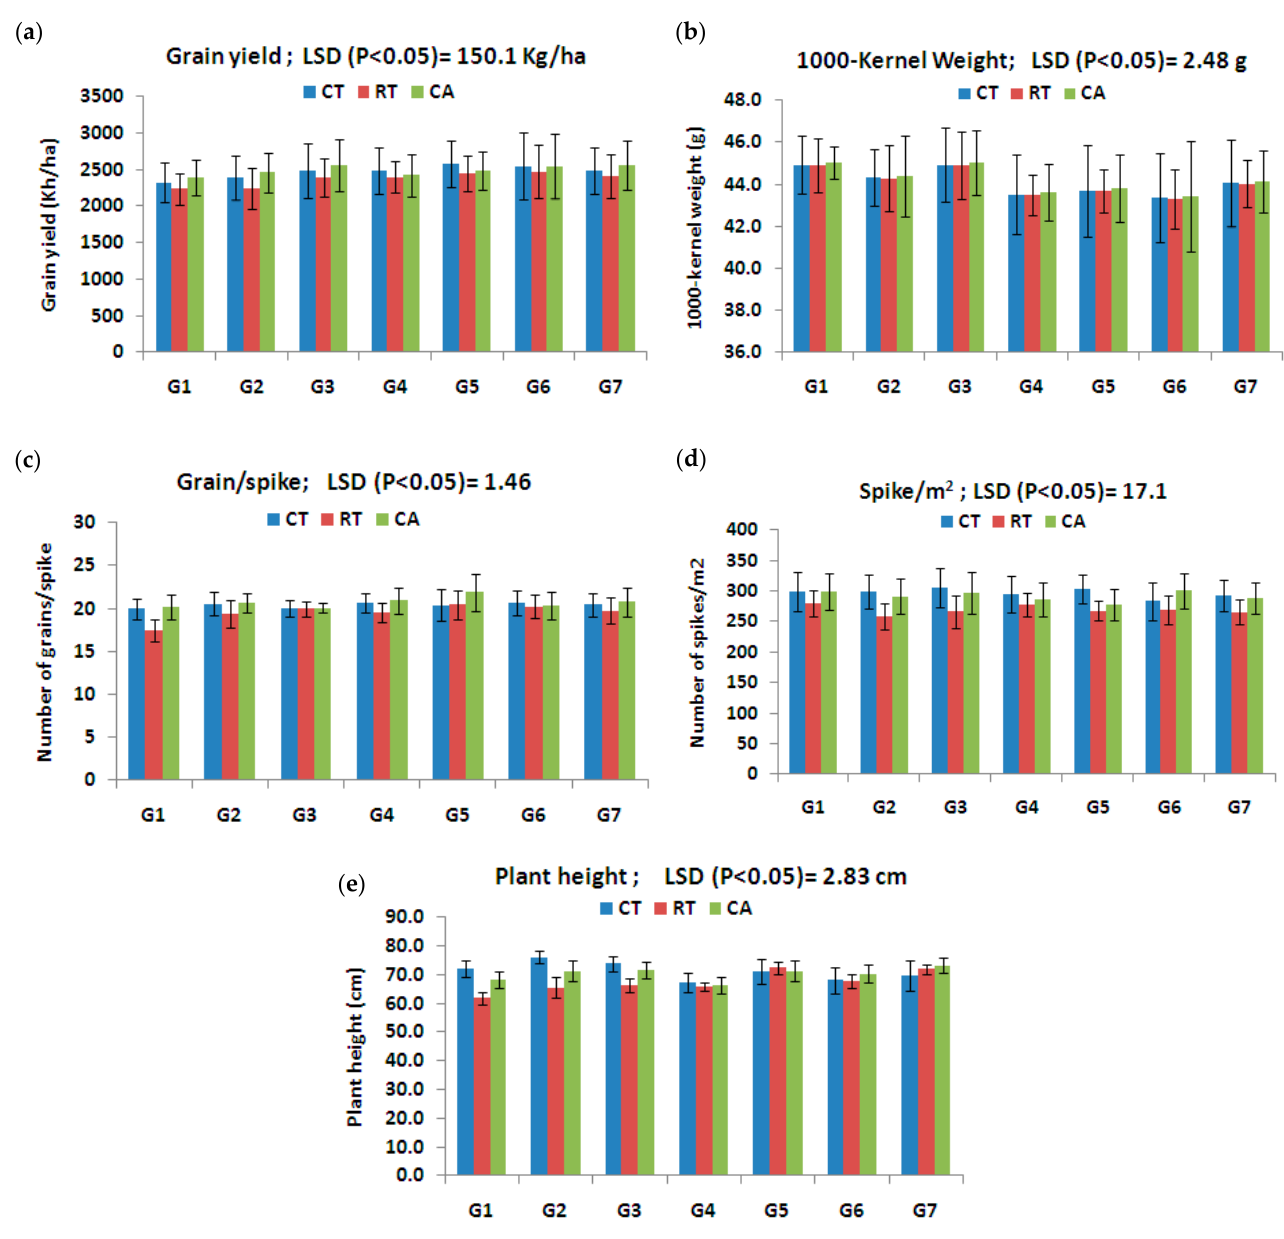
Figure 2. Genotype × tillage interaction for grain yield and related traits of seven barley genotypes (G1–G7) across locations and years. ( a ) Grain yield of barley genotypes under the effects of different tillage systems. ( b ) 1000-kernel weight of barley genotypes under the effects of different tillage sys- tems. ( c ) Grain/spike of barley genotypes under the effects of different tillage systems. ( d ) Spike/m 2 of barley genotypes under the effects of different tillage systems. ( e ) Plant height of barley genotypes under the effects of different tillage